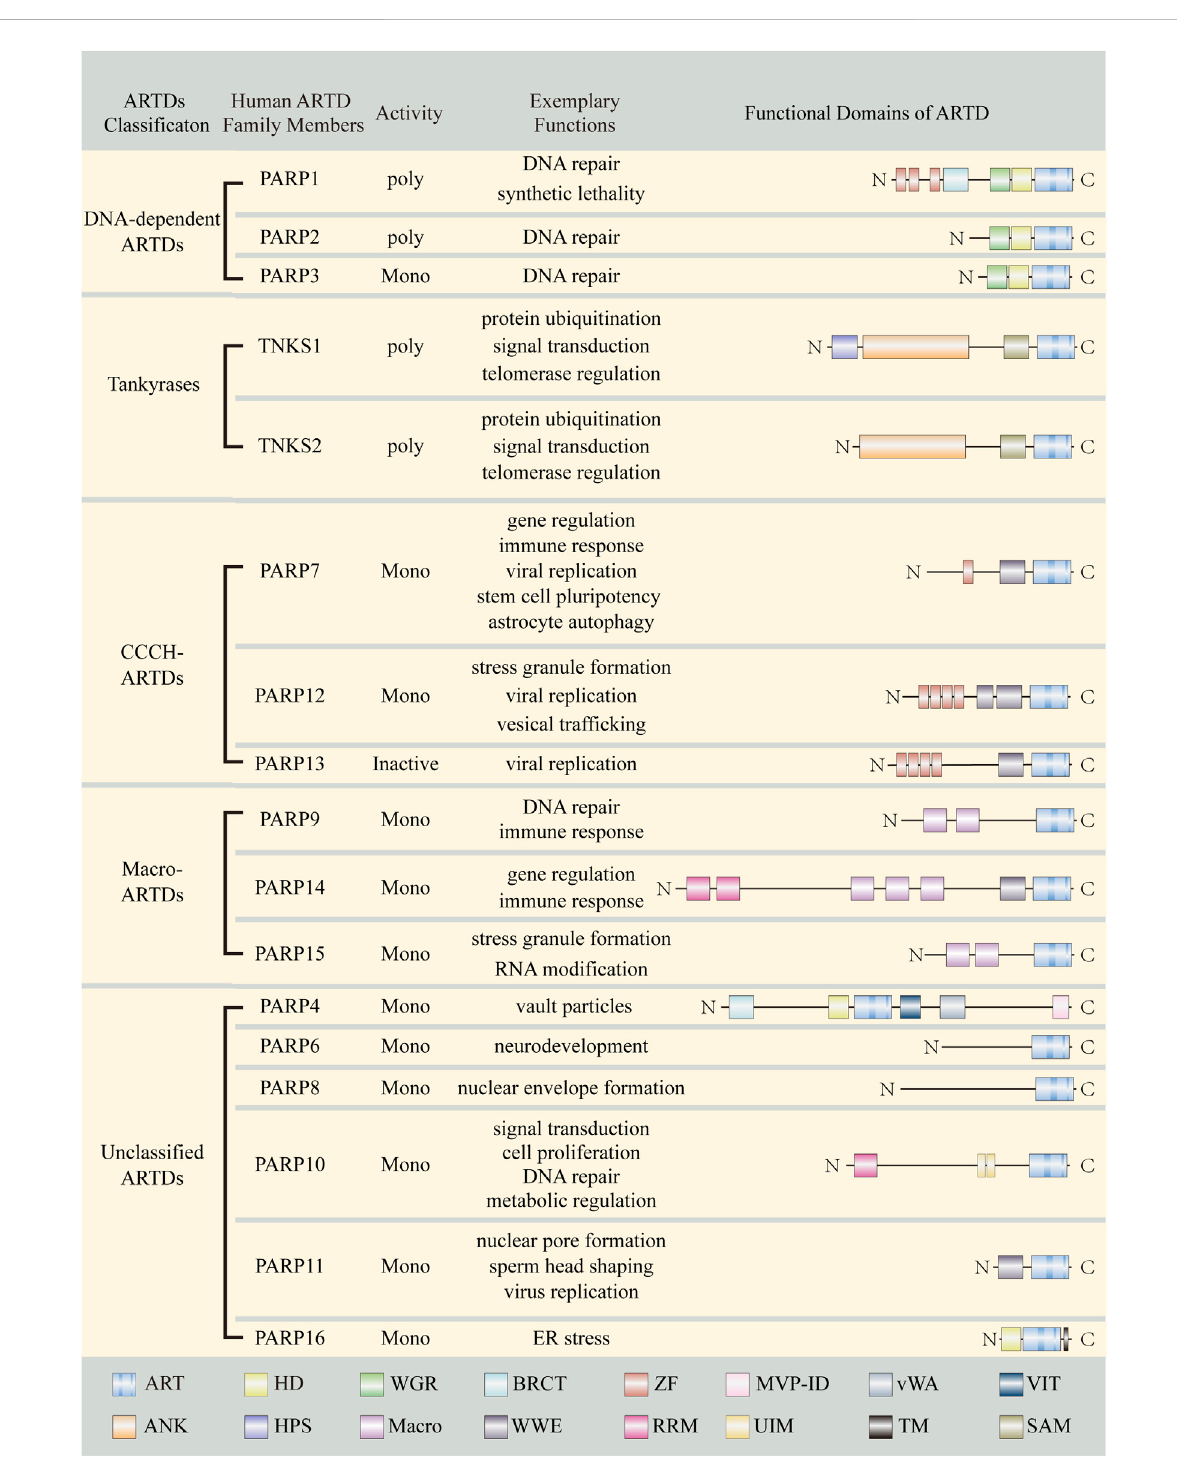
FIGURE 2 Summary of ARTD family members. Important domains of ARTD family members are indicated with different color boxes. ART, ADP- ribosyltransferase domain; HD, helical domain; WGR, Trp-Gly-Arg motif; BRCT, BRCA1 C-terminus-like motif; ZF, Zinc fi nger; MVP-ID, M-vault particle interaction domain; vWA, von Willebrand factorm type A; VIT, vault protein inter-alpha-trypsin; SAM, sterile alpha motif; ANK, Ankyrin repeats; HPS, Histidine-proline-serine region; Macro, Macrodomain; WWE, Tryptophan (W)-Tryptophan (W)-Glutamate (E); RRM, RNA recognition motif; UIM, ubiquitin interaction motif; TM, transmembrane